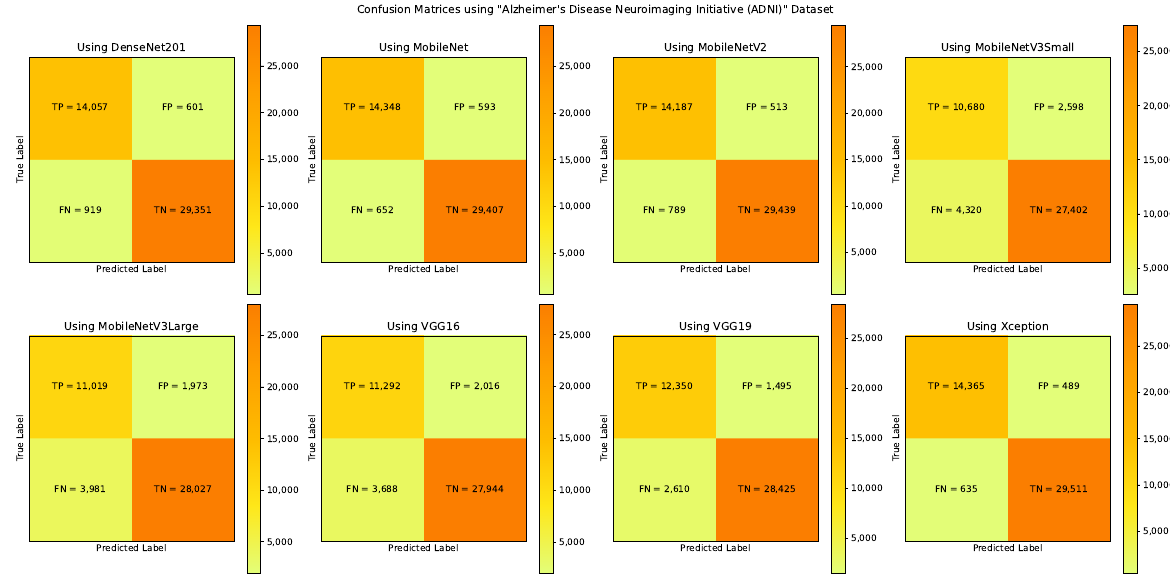
Figure 11. The confusion matrices using the “Alzheimer’s Disease Neuroimaging Initiative (ADNI)”